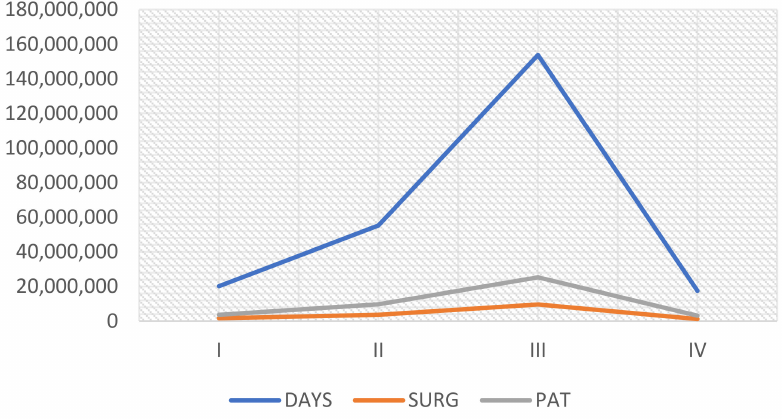
Figure 3. Hospital activity measured according to climate zones. Most of the hospitals are located in the third climate zone, which covers the most extensive area of Poland. More than 60% of hospital beds are located in this climate zone, which accompanies the highest percentage of treated patients (60.60%) and performed surgeries (59.70%). Accordingly, more than 61% of nurses and doctors take care of patients in hospitals located in the third climate